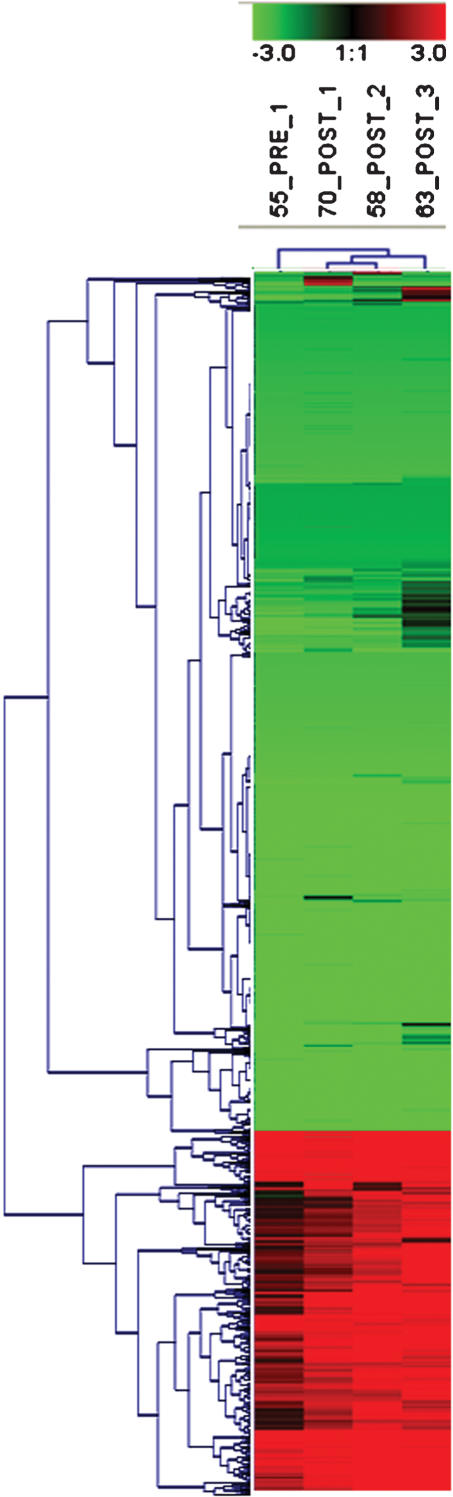
Hierarchical Cluster Analysis. The cluster shown represents 3,117 genes. Each row represents a gene, whereas each column corresponds to a tissue sample. The relative abundance of the gene in the tissue correlates with color intensity (red, induced; green, repressed; black, no change). On the dendogram, post-treated clinical samples clustered together.